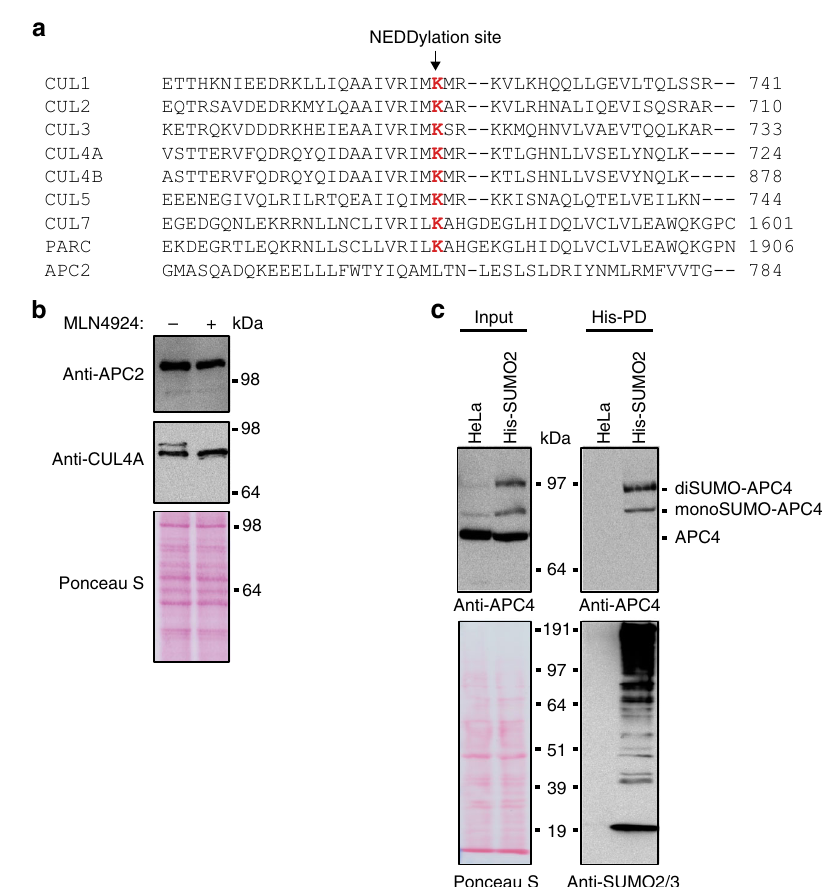
Fig. 2 Posttranslational modi fi cation of the APC/C by SUMOylation. a Alignment of the Cullin domains present in the human Cullin proteins and the Cullin- like domain of APC2: The NEDDylated lysine residue within the Cullin proteins is highlighted in red and is absent in APC2. b HeLa cells were treated with DMSO as a negative control ( − ) or 1 µ M MLN4924 ( + ), an inhibitor of the NEDD8-activating enzyme, for 16 h. Lysates were analyzed by immunoblotting with anti-APC2 and anti-CUL4A antibodies. Ponceau S staining was performed to monitor equal loading. c HeLa cells and HeLa cells expressing His-tagged SUMO2 (His-SUMO2) were subjected to a His-pulldown (His-PD). Input and pulldown samples were analyzed by immunoblotting making use of anti- APC4 and anti-SUMO2/3 antibodies. Blots were stained with Ponceau S to monitor equal loading. At least three independent experiments were performed and representative results are